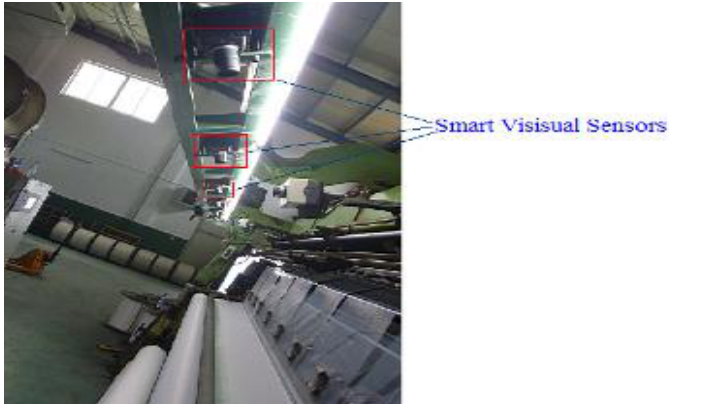
Figure 15. Layout of smart visual sensors for fabric inspection on warp knitting